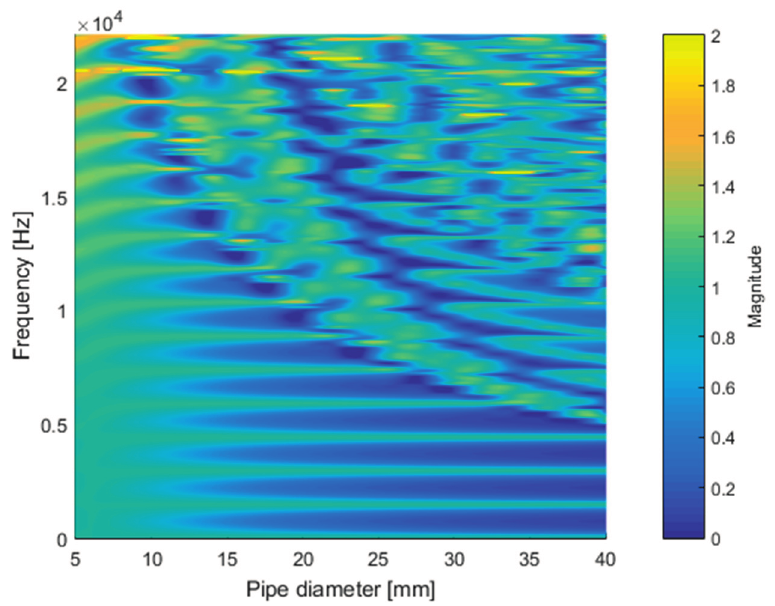
Figure 5. Simulated frequency response of cylindrical pipe ( l = 117.7 mm, h = 3 mm, and w = 8 mm) with various